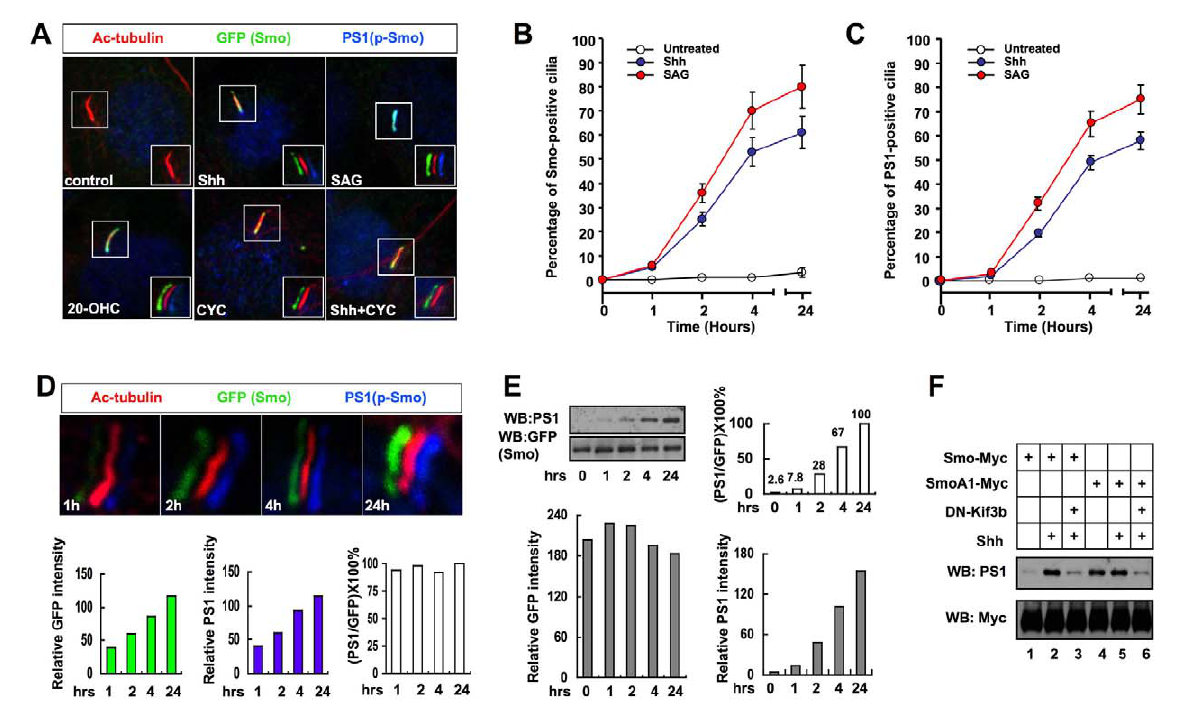
Figure 6. Smo phosphorylation at the primary cilium. (A) NIH 3T3 cells stably expressing Smo-CFP were either untreated (control) or treated with Shh-conditioned medium (Shh), SAG (200 nM), 20-OHC (10 m M), CYC (10 m M), or a combination of Shh-conditioned medium and CYC (10 m M). Cells were immunostained to show the expression of acetylated tubulin (red; primary cilium), GFP (green; Smo), and PS1 (phosphorylated Smo; blue). Images in the insets are shifted overlays of the selected fields. (B–C) The percentage of Smo-CFP (GFP) or phosphorylated Smo (PS1) positive primary cilia at different time after cells were treated with or without Shh or SAG (200 nM). Over 100 ciliated cells were counted for each time point, n =3. (D) NIH 3T3 Smo-CFP cells were treated with 200 nM SAG for 1, 2, 4, or 24 h, followed by immunostaining to show the expression of acetylated tubulin (red), GFP (green), and PS1 (blue). Representative images with shifted overlay were shown for each time point. Histograms underneath show the relative intensities of PS1 or GFP fluorescence signals and their ratios (PS1/CFP) at each time point. The ratios are normalized to that of 24 h time point, which is set at 100%. (E) NIH 3T3 Smo-CFP cells were treated with Shh-conditioned medium for 0, 1, 2, 4, or 24 h. Cell extracts at each time point were separated on SDS-PAGE and probed with the indicated antibodies. Histograms show the relative intensities of PS1 and GFP bands quantified by the ImageJ software and their ratio (PS1/CFP) normalized to that at 24 h. (F) Cell extracts prepared from NIH 3T3 cells transfected with the indicated constructs and treated with or without Shh-conditioned medium were subjected to western blot analysis with the indicated